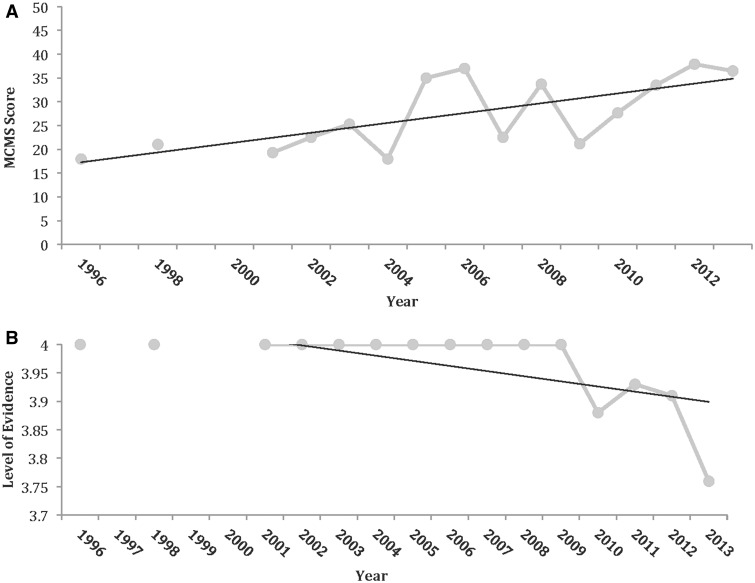
(A) Mean MCMS over time for all continents combined. (B) Mean level of evidence over time for all continents combined. Note that lower numerical level of evidence is observed over later publication date, indicative of improved, rather than worse, level of evidence.